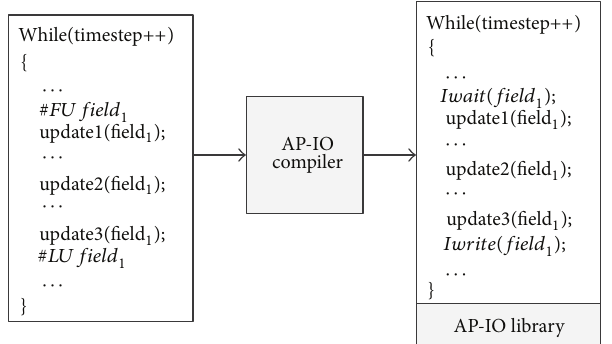
Figure 5: Framework of AP-IO